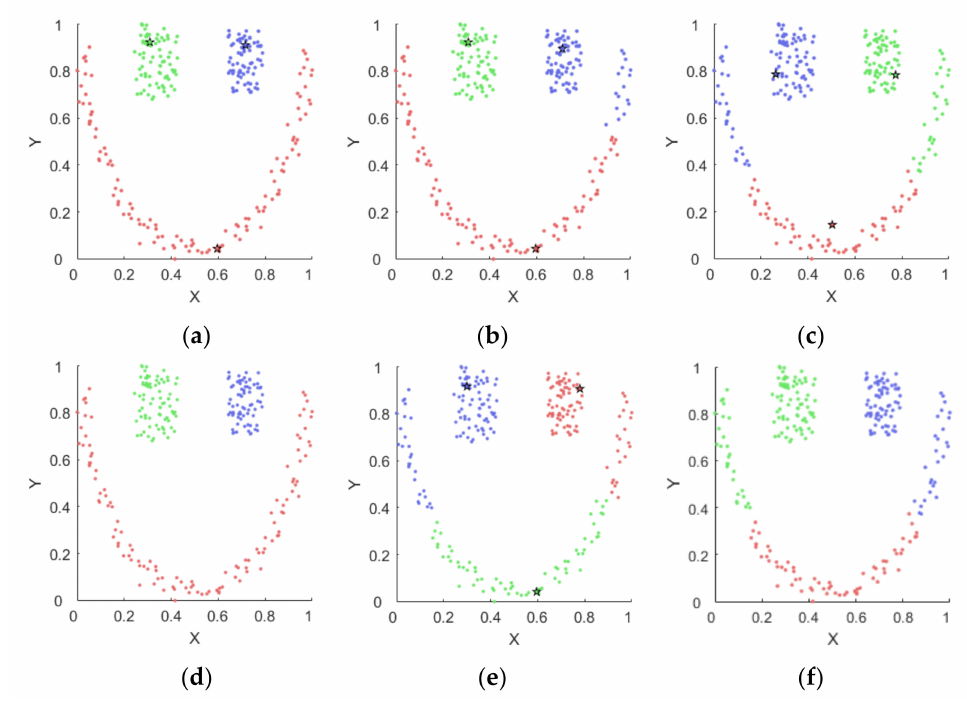
Figure 9. Results on HalfCircle. ( a ) ConDPC, ( b ) DPC, ( c ) K-means, ( d ) DBSCAN, ( e ) DPC-DBFN, ( f )